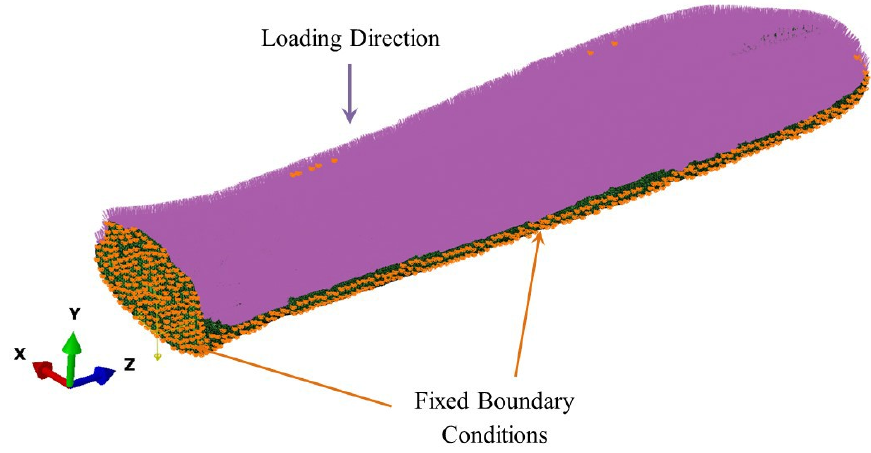
Figure 12. Force and displacement boundary conditions implemented on the rostrum.